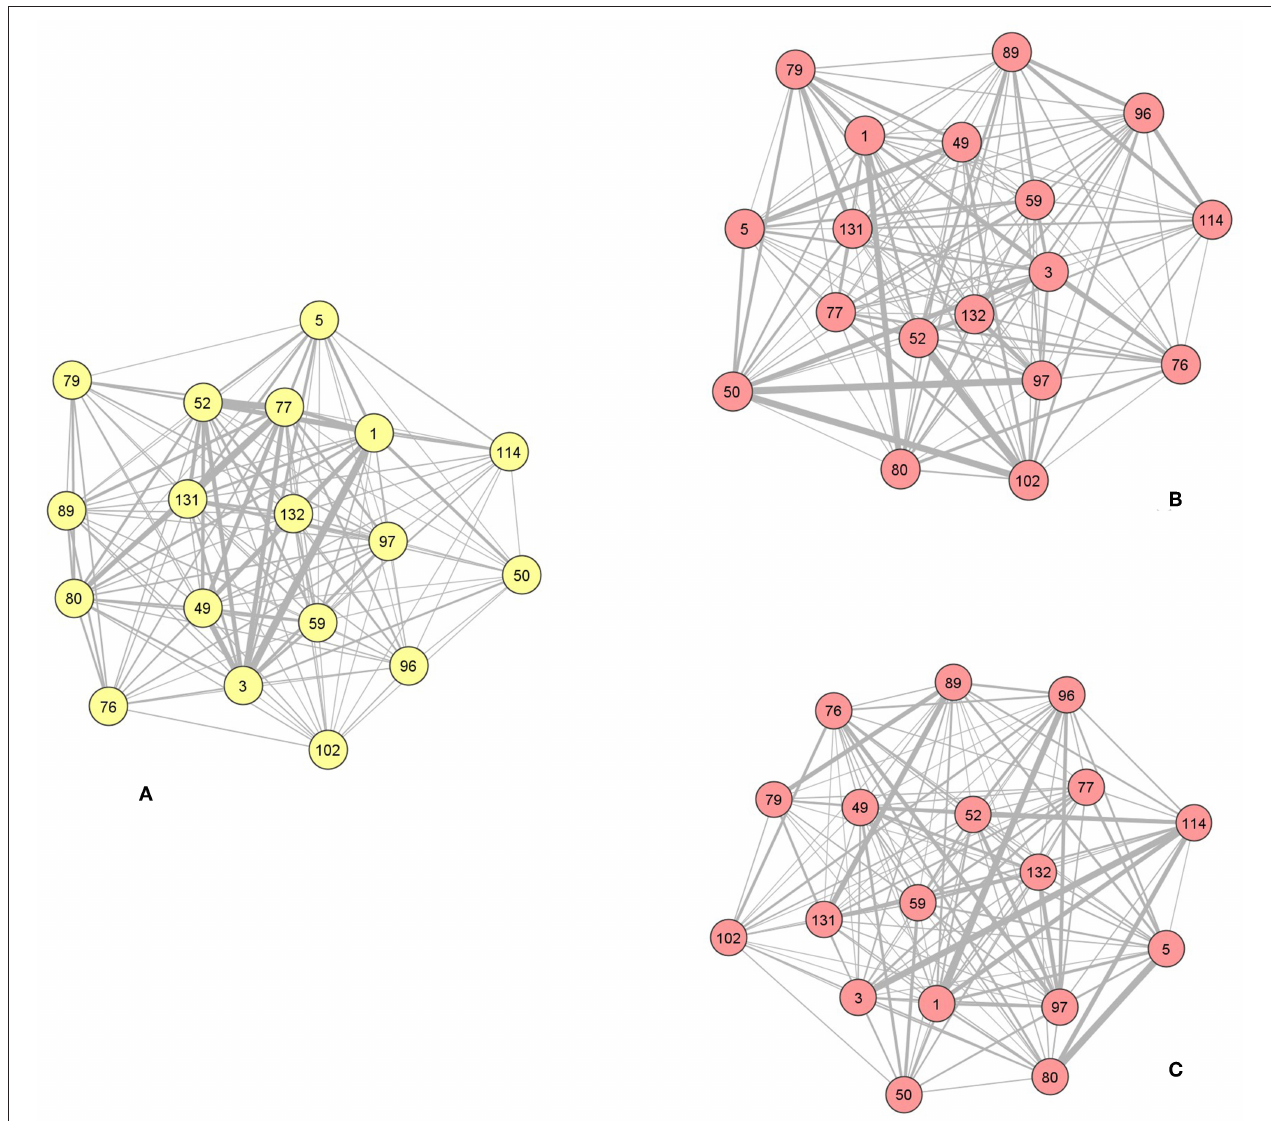
FIGURE 3 | Example of the process of network randomization through link reshuffling. Middle network ( A observed, B,C